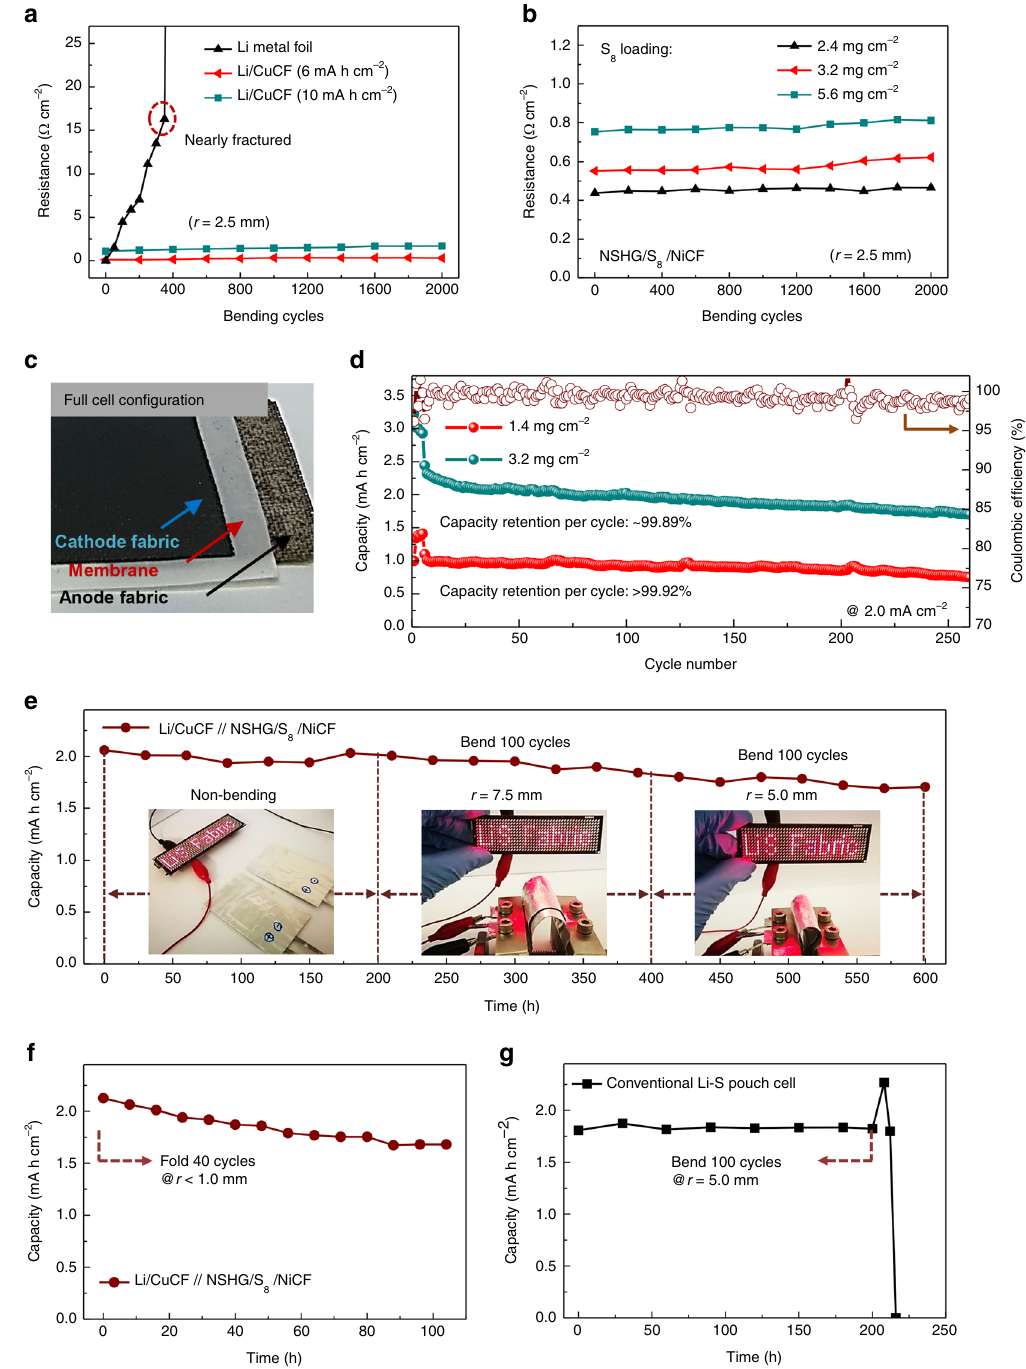
Fig. 5 Cycling stability and mechanical durability of lithium-sulfur full batteries. a , b Sheet resistances of the electrodes (lithiated copper-deposited carbon fabric, Li/CuCF and NSHG/S 8 /NiCF where NSHG is nitrogen and sulfur heavily doped graphene and NiCF is nickel-deposited carbon fabric) as a function of bending cycles at a given bending radius ( r = 2.5 mm). c Digital picture of the inner cell con fi guration in full-cell Li-S batteries. A fl exible microporous separator is used for separating two kinds of composite fabrics (NSHG/S 8 /NiCF as cathode and Li/CuCF as anode). d Cycling stability of Li-S full batteries at high current densities of 1 mA cm − 2 and 2 mA cm -2 . The sulfur cathode of NSHG/S 8 /NiCF with different sulfur loadings of 1.4 mg cm -2 and 3.2 mg cm − 2 was paired with a limited amount of Li/CuCF (6 mA h cm − 2 ) to study the cycling performance. e Areal capacities of our Li-S full cells with a size of 4 cm − 2 are recorded at 1 mA cm − 2 for 150 cycles, during which 200 repeating bents at 5 mm radius are carried out. To demonstrate fl exible and wearable applications, two batteries of a size of 4 cm − 2 are connected in series to yield an open circuit voltage of 4.2 V and a high areal capacity of 4 mA h cm − 2 . The tandem cell can be used for powering 264 LEDs-array screens for tens of minutes. The array screen can display a clear caption of “ Li S Fabric ” , although the Li-S batteries as a power supplier were harshly bended at various bending radius of (i) r = ∞ , (ii) r = 7.5 mm, (iii) r = 5 mm, as shown in the inset. f Areal capacities of Li-S full cells with a size of 4 cm − 2 are recorded at 2 mA cm − 2 for 50 cycles, during which 40 repeating folds are performed at a folding radius of <1 mm. g Areal capacities of conventional Li foil-based Li-S pouch cells with a size of 4 cm − 2 are recorded at 1 mA cm − 2 for 53 cycles and 100 repeating bends at 5 mm radius are conducted after the 50th